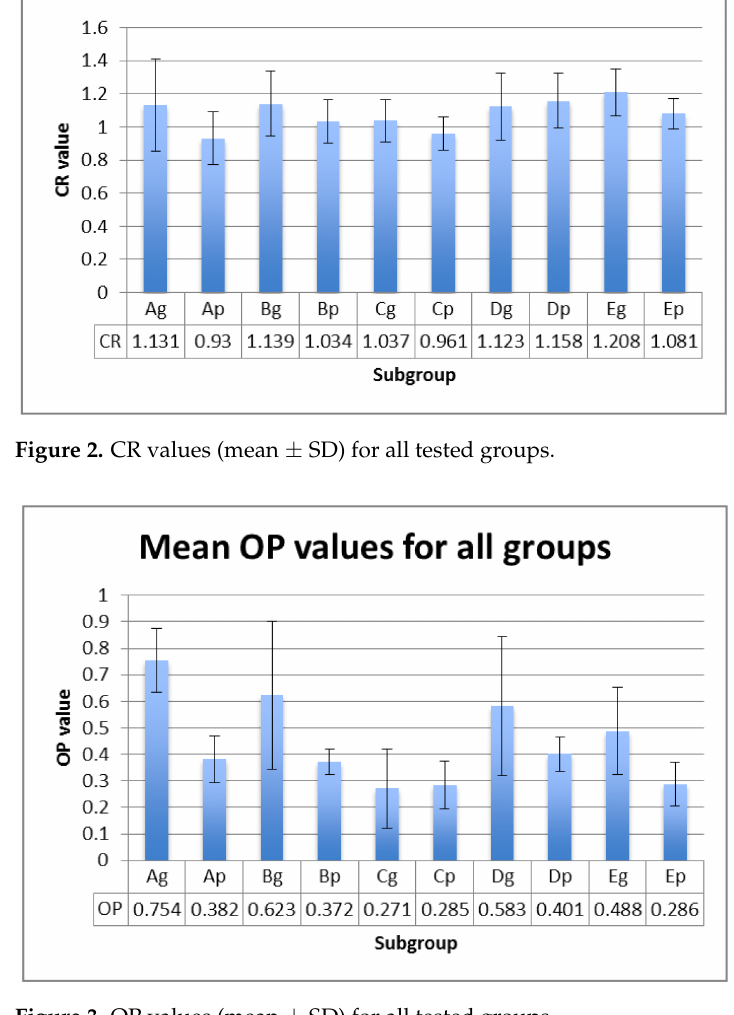
Figure 3. OP values (mean ± SD) for all tested groups.